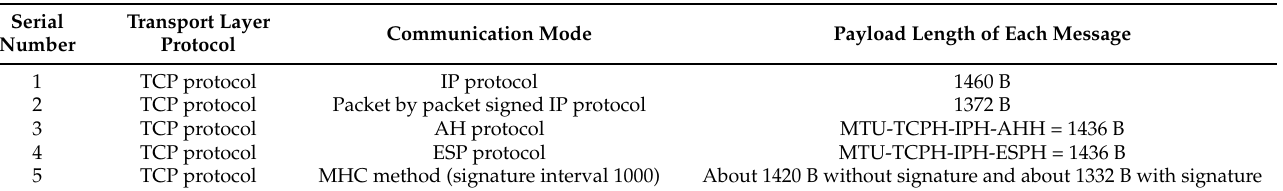
Table 2. Information about test